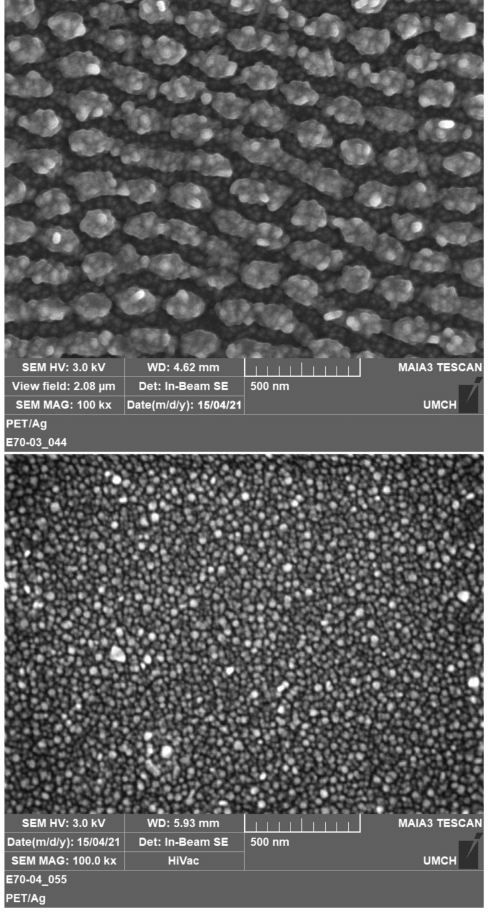
Figure 5. FEGSEM micrographs showing the surface morphology of PET after its irradiation in the presence of AgNPs colloids of different Ag concentrations: 15 mg L − 1 (up) and 30 mg L − 1